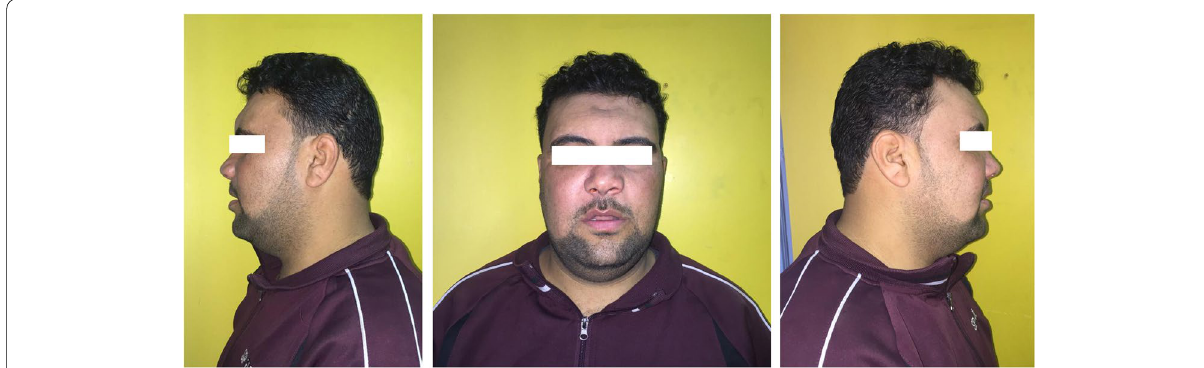
Fig. 9 Photograph of the patient 4 weeks after the